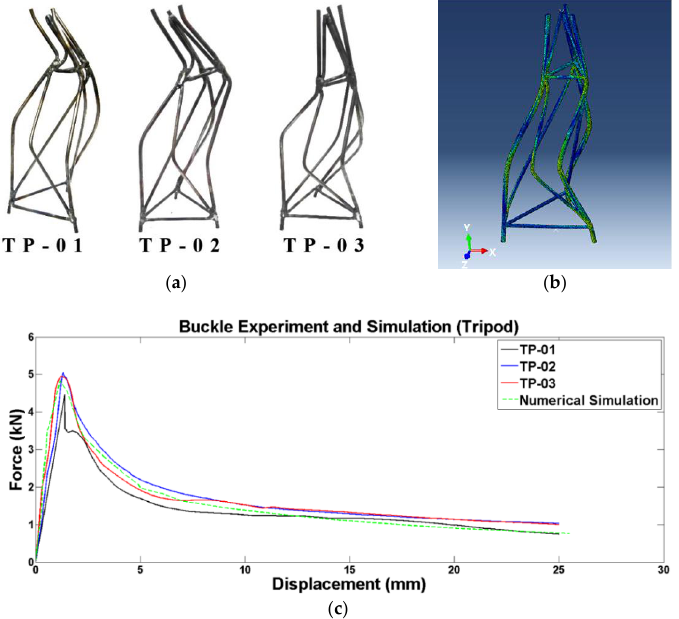
Figure 3. After compression deformation patterns of the scaled-down ( a ) experimental test specimens and ( b ) the numerical model; ( c ) a diagram of the load-displacement test results from unstable collapse and postbuckling analysis.